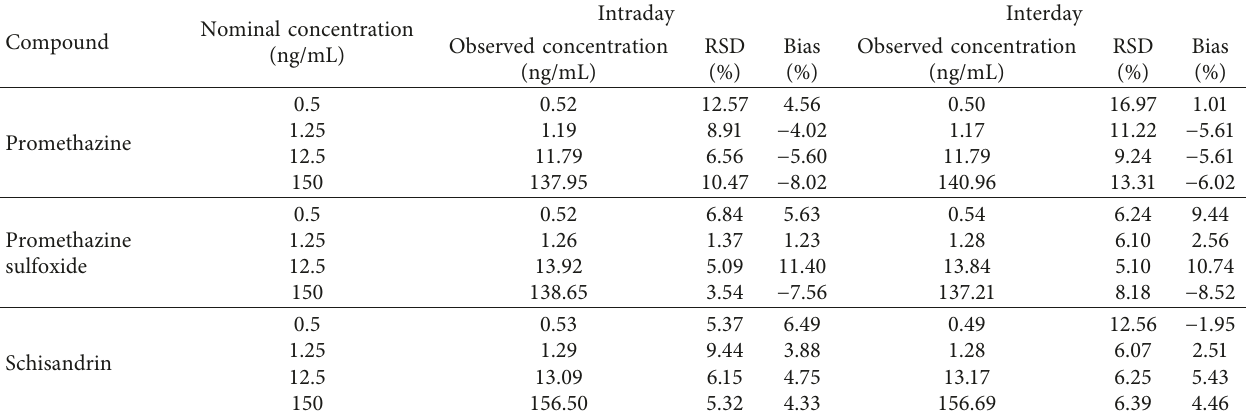
Table 3: Intra- and interday precision (RSD, %) and accuracy (bias, %) of QC